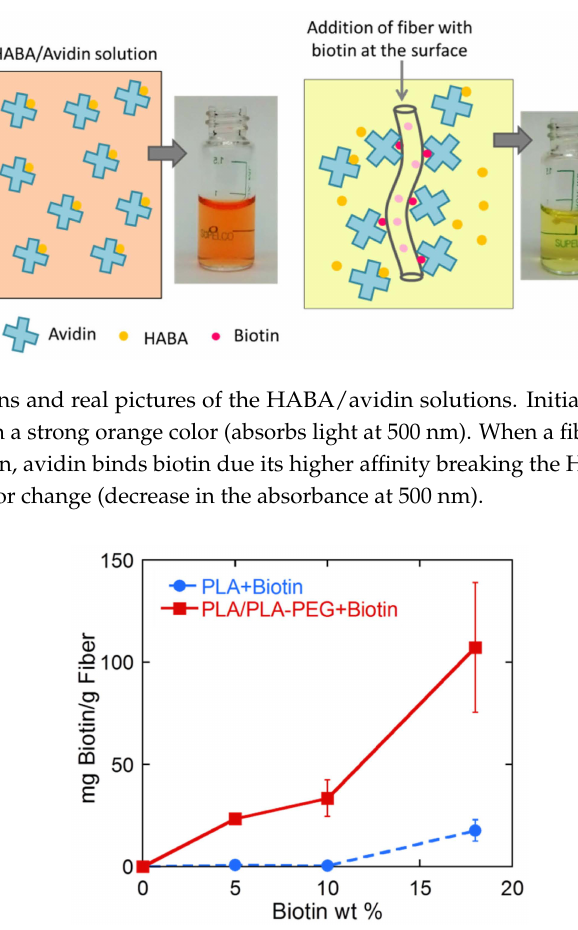
Figure 6. Surface available biotin of PLA and PLA/PLA- b -PEG samples containing different amounts of overall